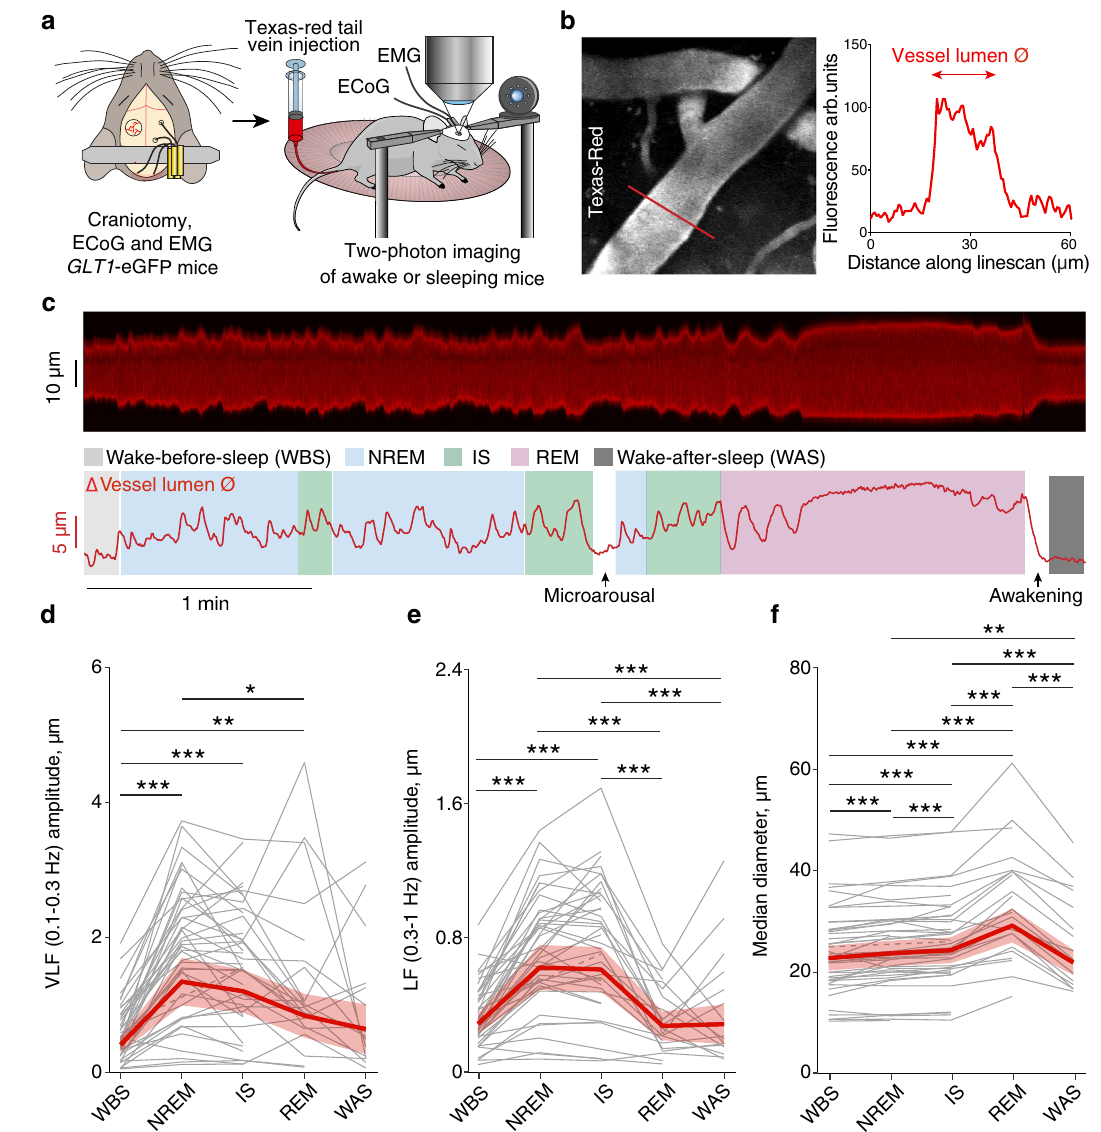
Fig. 1 | NREM, IS and REM sleep states are associated with speci fi c pial artery diameter changes. a Experimental setup. GLT1 -eGFP transgenic mice were fi tted with a cranial window exposing the somatosensory cortex, ECoG electrodes and EMG electrodes. The vasculature was outlined with Texas Red-labeled dextran. b ( Left )Representative image ofapialarterywith Texas-Redlabeleddextraninthe lumen. Imaging was performed by placing cross sectional x-t line scans. Linescan length60 μ m.( Right )Vessellumendiameter(Ø)wasdeterminedalongalineacross the vessel. Experiment was repeated on 44 pial arteries from 5 mice. c Representative traces of a pial artery line scan and change in vessel lumen dia- meter(Ø)duringasleepcycle. d Amplitudeofverylowfrequency(VLF0.1 – 0.3Hz), e amplitude of low frequency (LF 0.3 – 1Hz) oscillations and f median diameter of pial artery lumen throughout a sleep cycle. Every gray line (dashed or full)